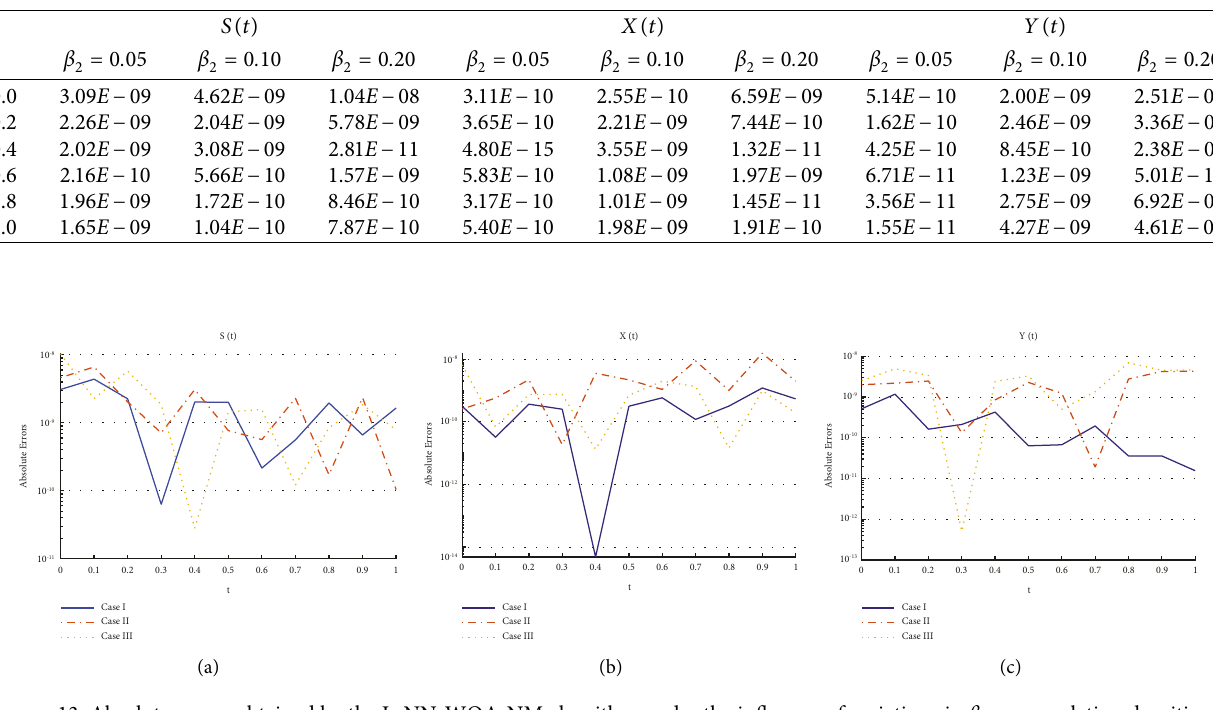
Table 29: Absolute errors obtained by the LeNN-WOA-NM algorithm for population densities of local prey, immigrant prey, and predator under the influence of the negative impact of the force of interaction on immigrant prey β